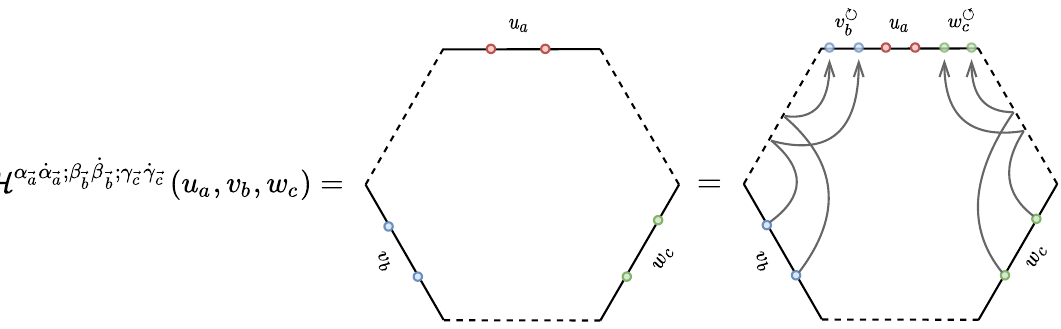
Figure 9 . To obtain a correlator with all excitations on top we perform one crossing transformation in the left ( (cid:8) ) and another in the right ( (cid:9) ). These monodromies will change the Zhukovsky variables as well as the indices of the